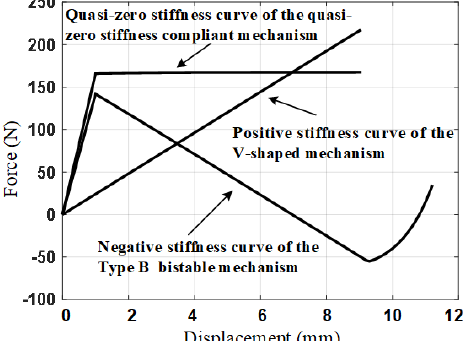
Figure 12. The force–displacement curve of the Type B bistable linear negative-stiffness mechanism, V-shaped positive-stiffness mechanism and quasi-zero stiffness compliant mechanism.